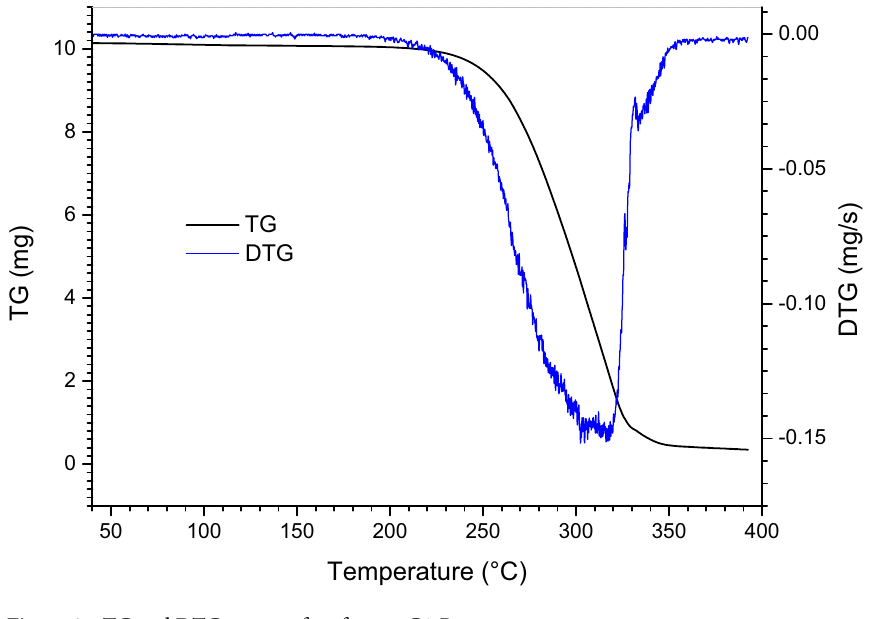
Figure 3. TG and DTG curves of surfactant